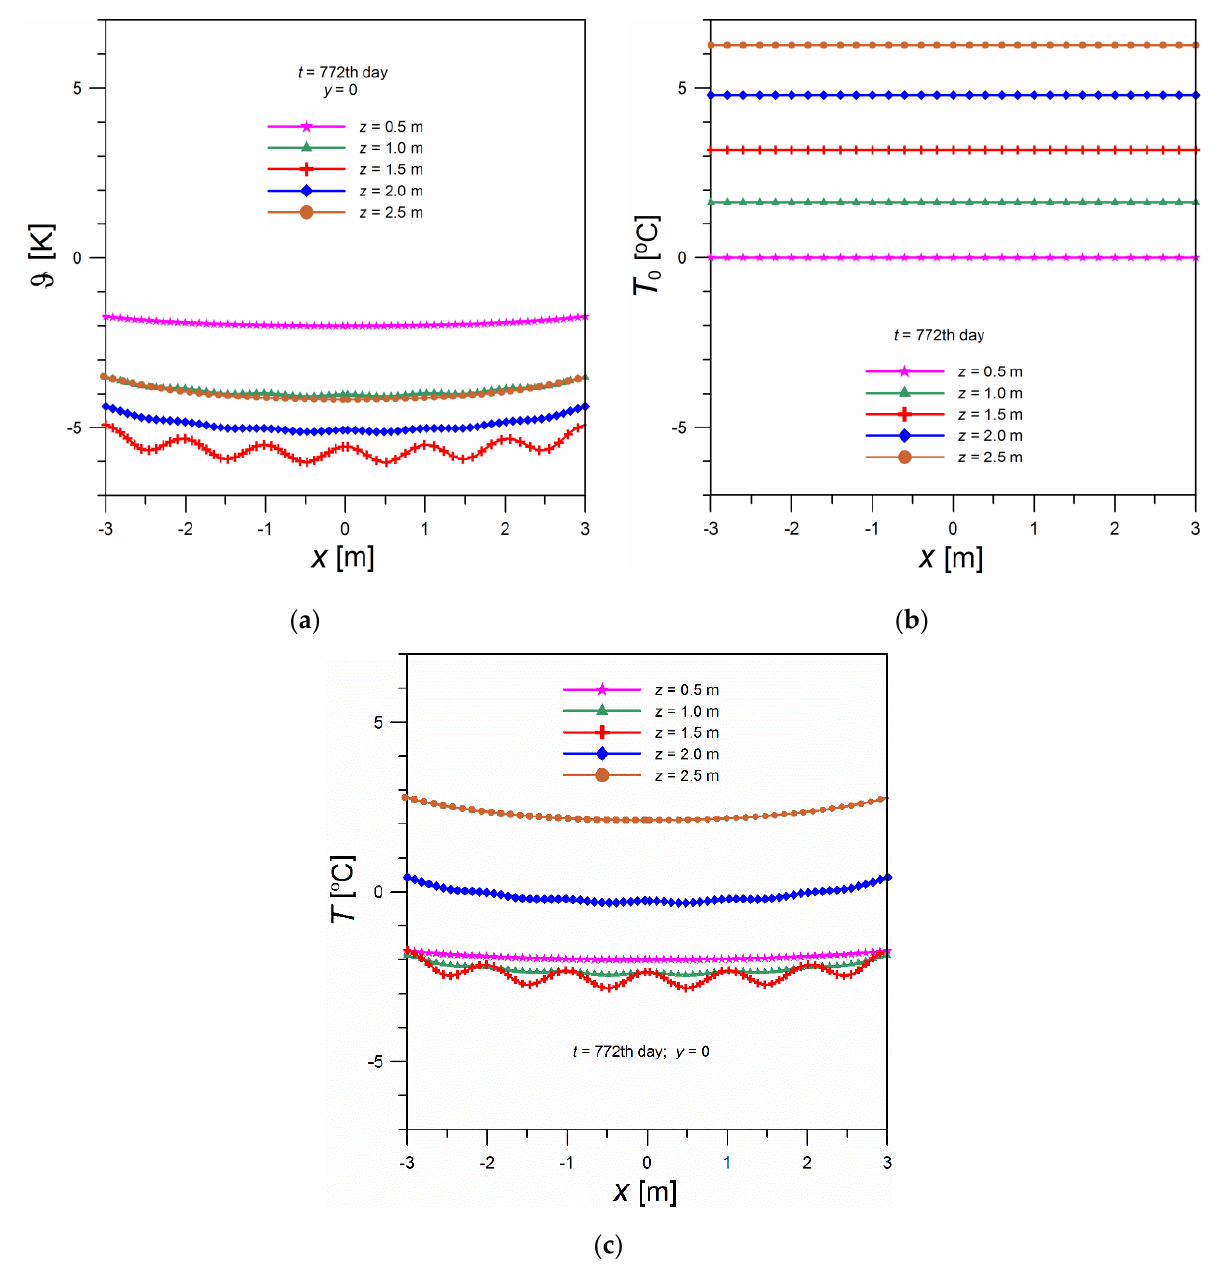
Figure 8. Ground temperature profiles along the x axis: ( a ) temperature response caused by the heat source, ( b ) undisturbed ground temperature, ( c ) ground temperature.